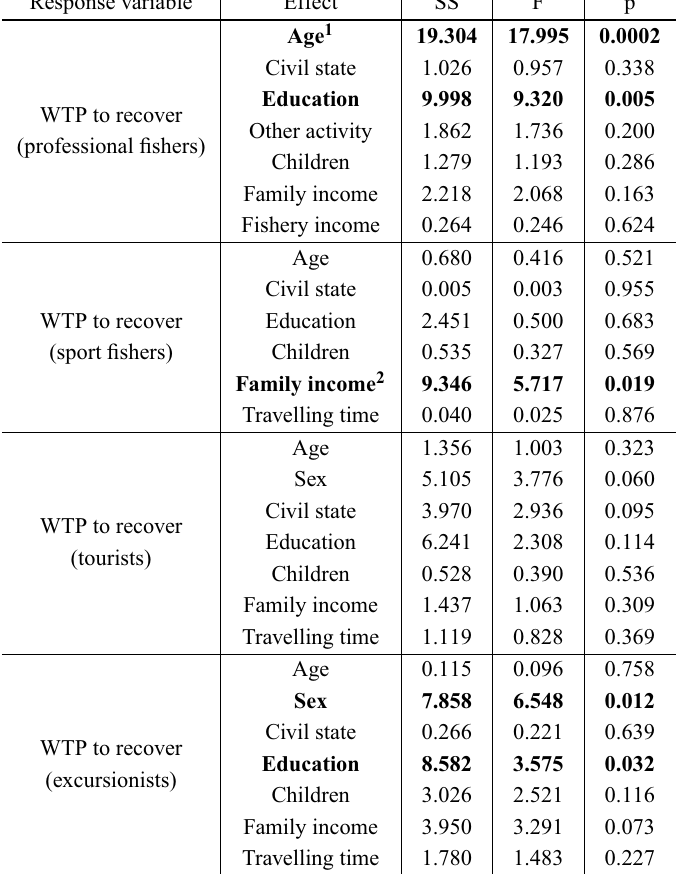
Results from the Analyses of covariance (ANCOVAs) on the Willing- ness to Pay (WTP) to recover the environment of the Emas waterfall. Considering the overall model for the professional fishers: R 2 = 0.542; n = 32; sport fishers: R 2 = 0.080; n = 103; tourists: R 2 = 0.248; n = 45; and excursionists: R 2 = 0.175; n = 97. The response variable was transformed into ln(WTP+1) before all ANCOVAs.